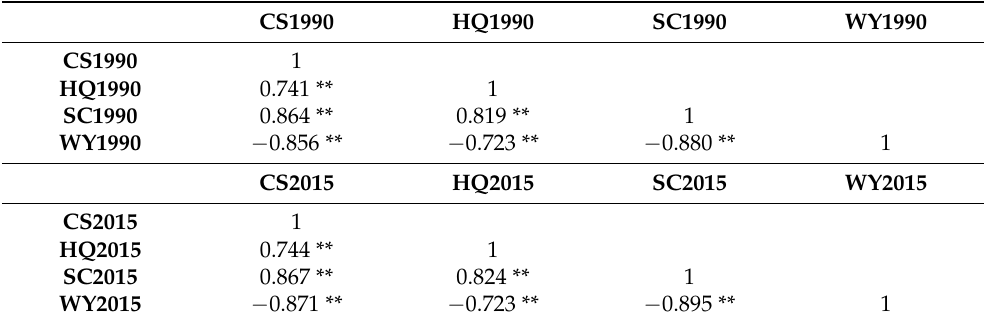
Table 3. Pearson’s correlation coefficient between ecosystem services in the LP, 1990, 2000, 2015 . CS1990 HQ1990 SC1990 WY1990 CS1990 1 HQ1990 0.741 ** SC1990 0.864 **